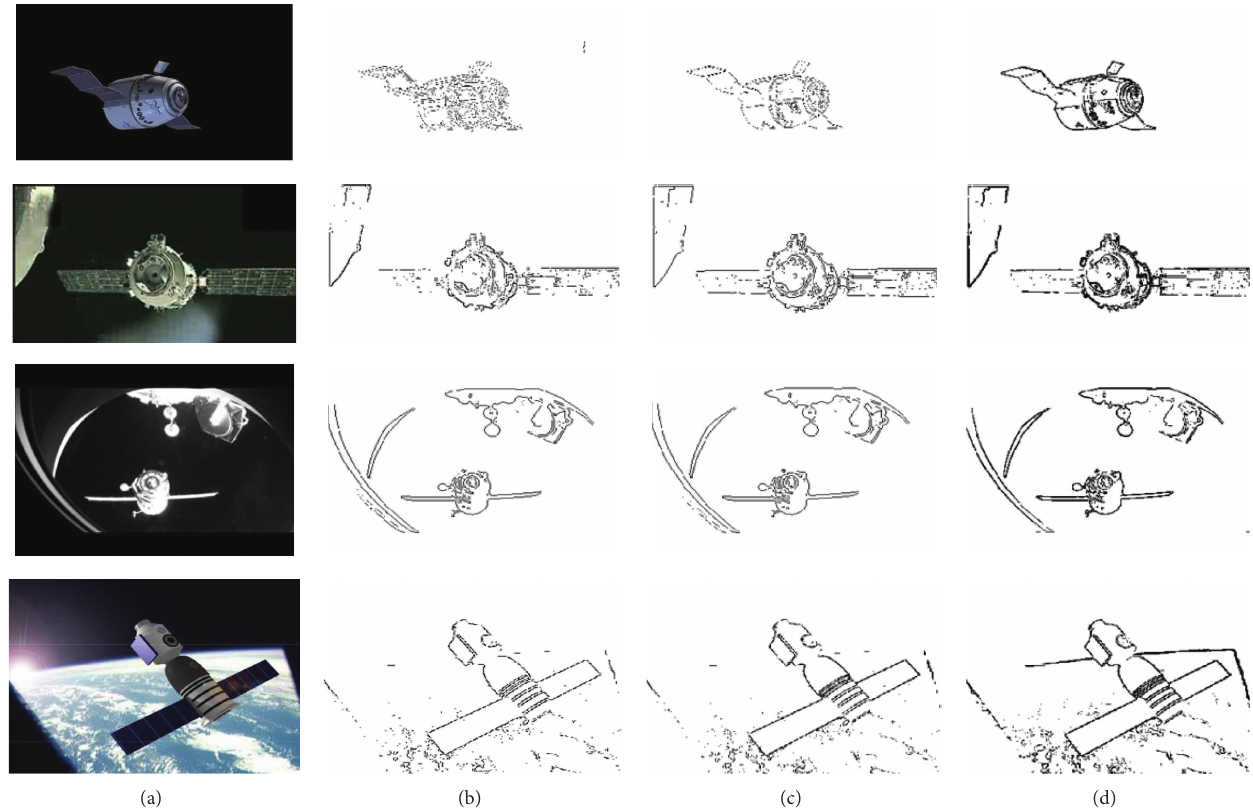
Figure 2: Contour evolution on spatial video sequences. (a) Original video frame and (b)–(d) contour evolution from a coarse to fine scale.